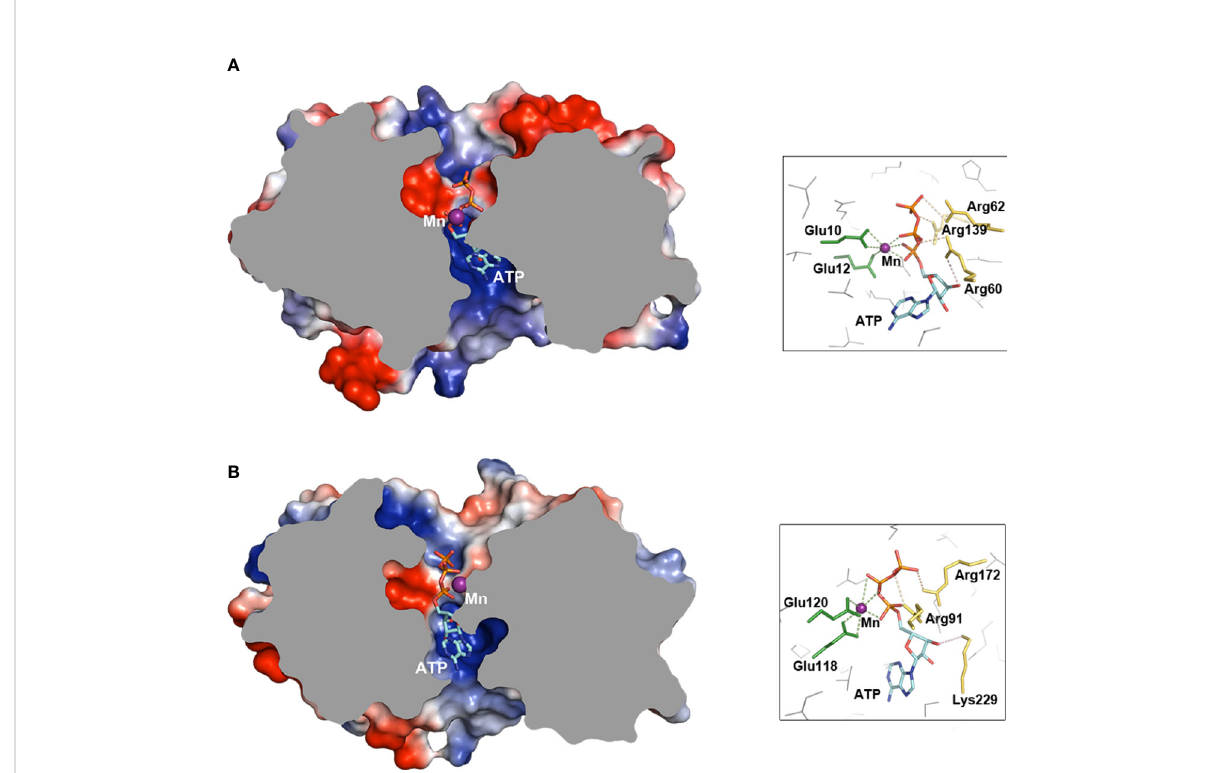
FIGURE 5 Docking simulations of ATP to MdTTM1 and MdTTM2. (A) Docking pose of substrate ATP to MdTTM1, free energy -8.3 (kcal/mol). (B) Docking pose of substrate to MdTTM2, free energy -8.4 (kcal/mol). The proteins are truncated from the middle to show the poses of ATP, and the insets show candidate functional residues that bind Mn and ATP. The icons on the right of proteins display functional residue coordinating ligands. The green broken lines represent coordination bonds to Mn 2+ (distance range, 2.2 to 2.8 Å). The light orange broken lines show the H-bonds between a protein and a ligand shorter than 3.5 Å. The light pink broken lines indicate a nucleophilic attack vector. ATP docking simulations were performed using AutoDock Vina (ver. 1.2.0), and images were created with PyMOL (ver.